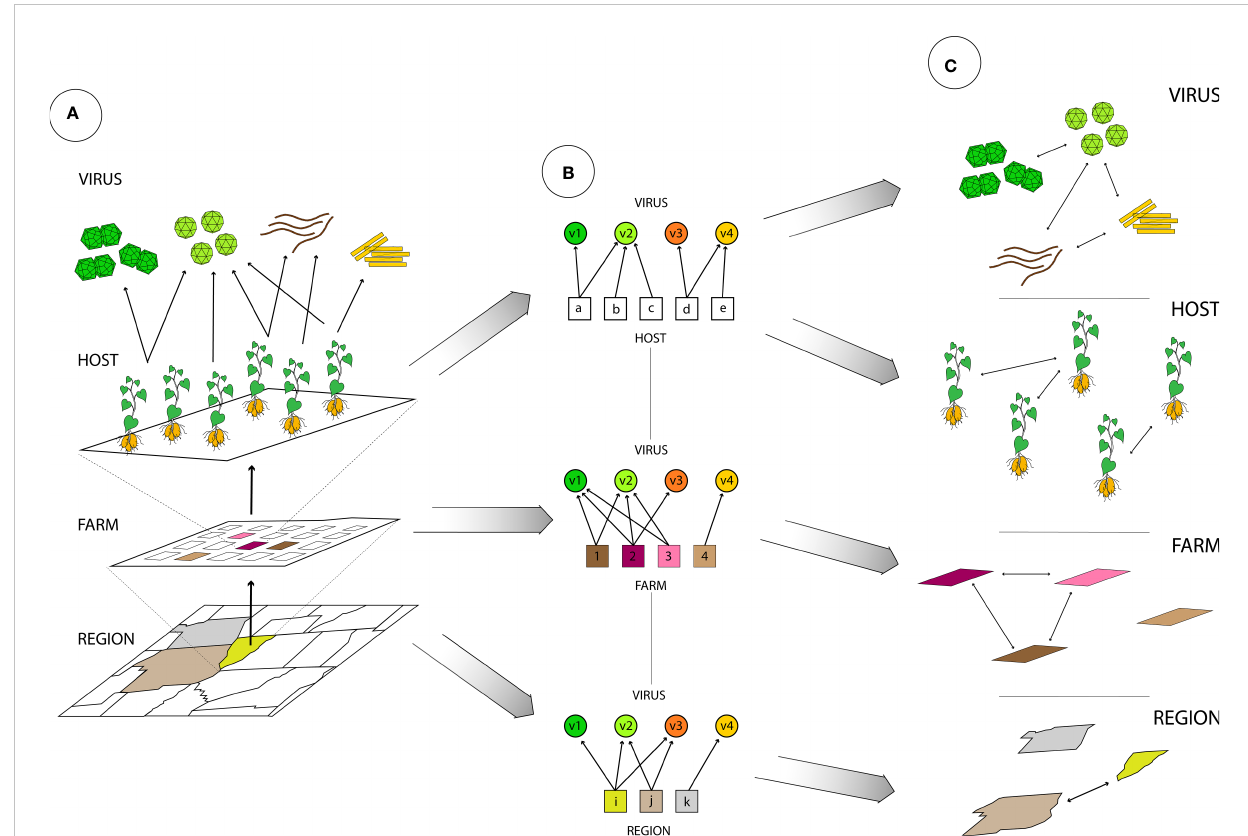
FIGURE 2 The spatial resolution of virome analysis, from low-resolution (counties and farms) to high-resolution (hosts), and virus associations at each scale. (A) Geographic representation of counties in a region, farms within a county, and hosts within a farm. Each layer could contain a different subset of viruses (a different virome). (B) Bipartite networks representing associations between two types of nodes, where circles represent viruses (v1 to v4), and where evaluation can be at multiple scales, for example: by region, where squares represent counties (i, j, k), by farm, where squares represent plots (1 to 4), and by host, where squares represent individual plants (a to e). (C) A one-mode network, where links between viruses represent their shared geographic or host associations and links between locations indicate similarity of their viromes, by region or by farm. Links between hosts represent similar